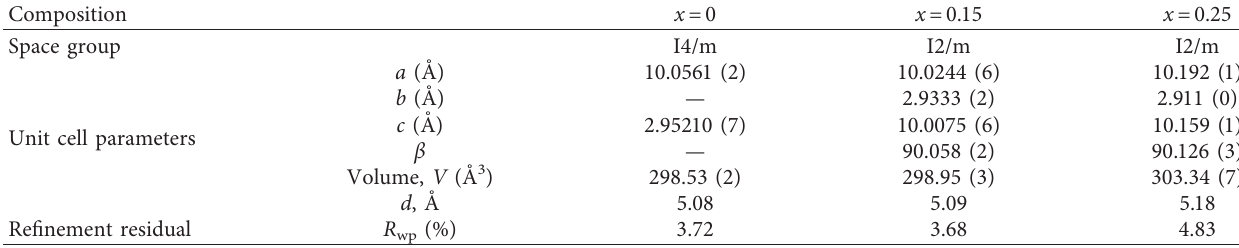
Table 3: Unit cell dimensions and fit parameters from the Rietveld refinement of Ba